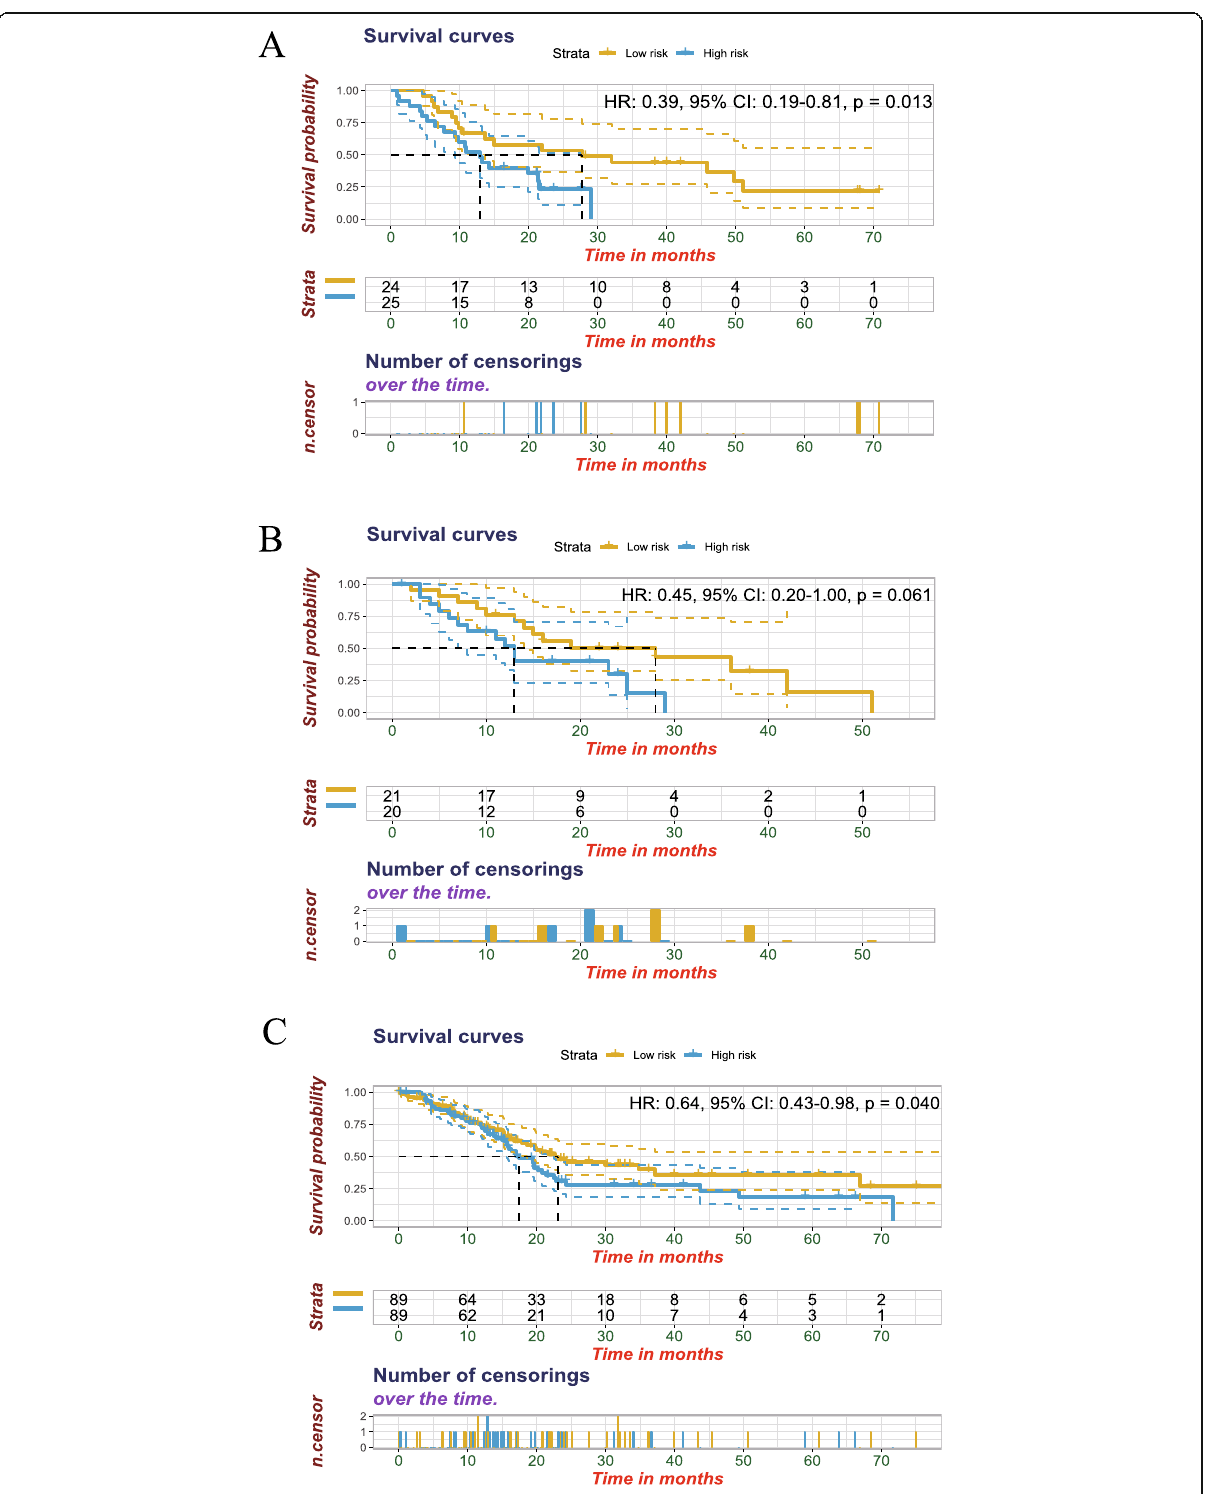
Fig. 6 Four-gene prognostic model of pancreatic cancer in training and validation cohort. a Construction of prognostic risk model of pancreatic cancer in training cohort-GSE78229. Yellow and blue represent patients with low and high risk scores. We defined high risk group as risk score ≥ median, low risk group as risk score < median. b Validation of prognostic risk model of pancreatic cancer in GSE28735. c Validation of prognostic risk model of pancreatic cancer in TCGA. TCGA, The Cancer Genome